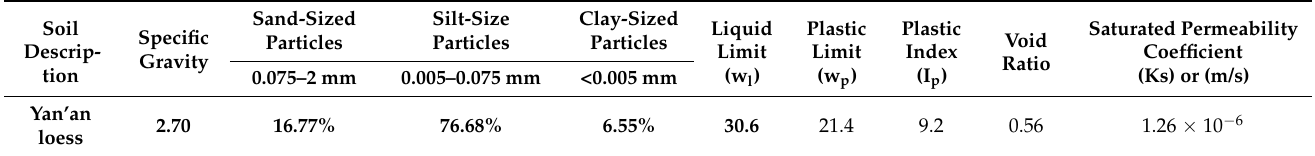
Table 1. Basic physical properties of the loess samples.